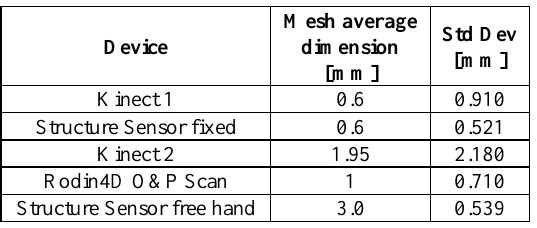
Table 4. Values of mesh size and standard deviation of the cloud to mesh distance for the hand models in respect to the one acquired with Minolta Vivid 9i.